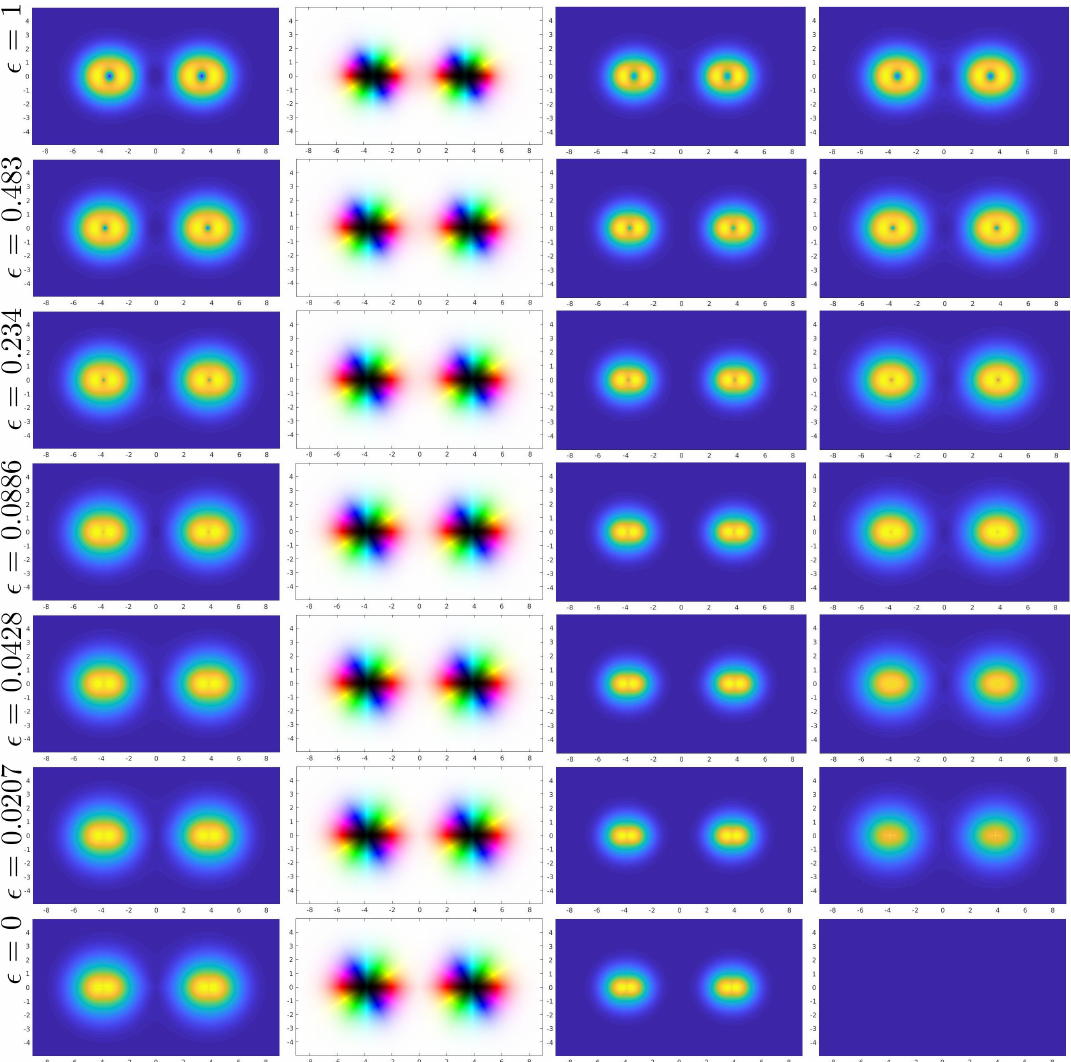
Figure 5. The Q = 2 + 2 baby Skyrmion for various values of (cid:15) ; this is the stable Q = 4 baby Skyrmion solution. The columns show the topological charge density, the pion vector orientation using a color scheme described in the text, the total energy density and the perturbation energy density (cid:15) ( −L + m 2 V 1 ) . In this figure m 1 = 0 . 5 2 1